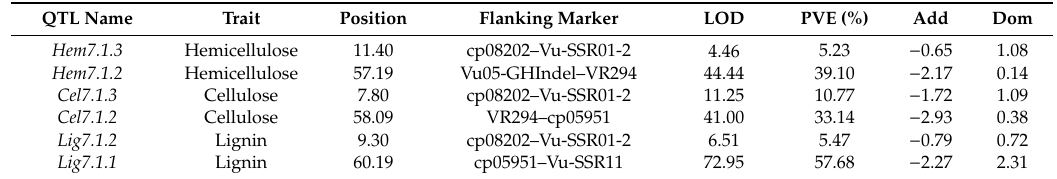
Table 3. Locations and e ff ects of QTLs identified for pod fiber contents in F 2:3 population of the cross JP81610 × TVnu-457 by inclusive composite interval